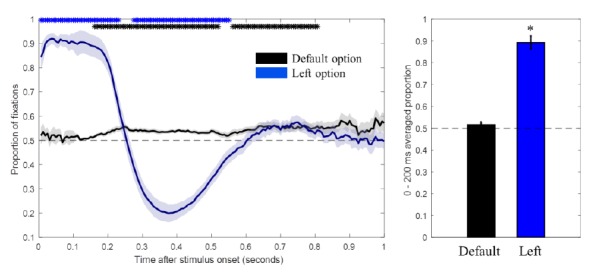
DOI:
http://dx.doi.org/10.7554/eLife.20317.013